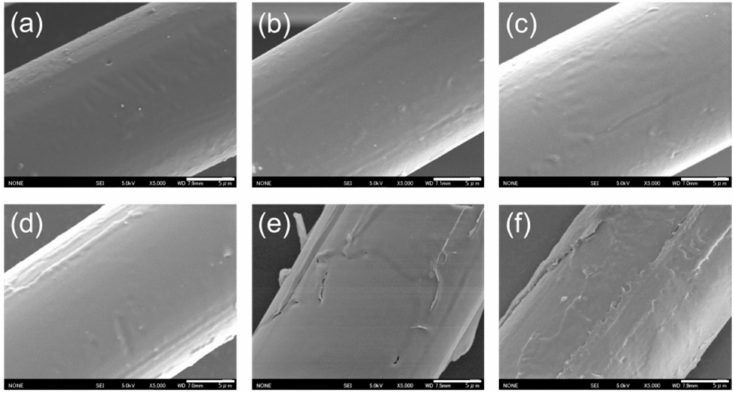
Figure 5. SEM images of CS-coated PLA fibers: ( a ) untreated PLA fiber; ( b ) C1; ( c ) C2; ( d ) C3; ( e ) C4; and ( f ) C5 (magnification: 5000 × , scale bar: 5 µ m).